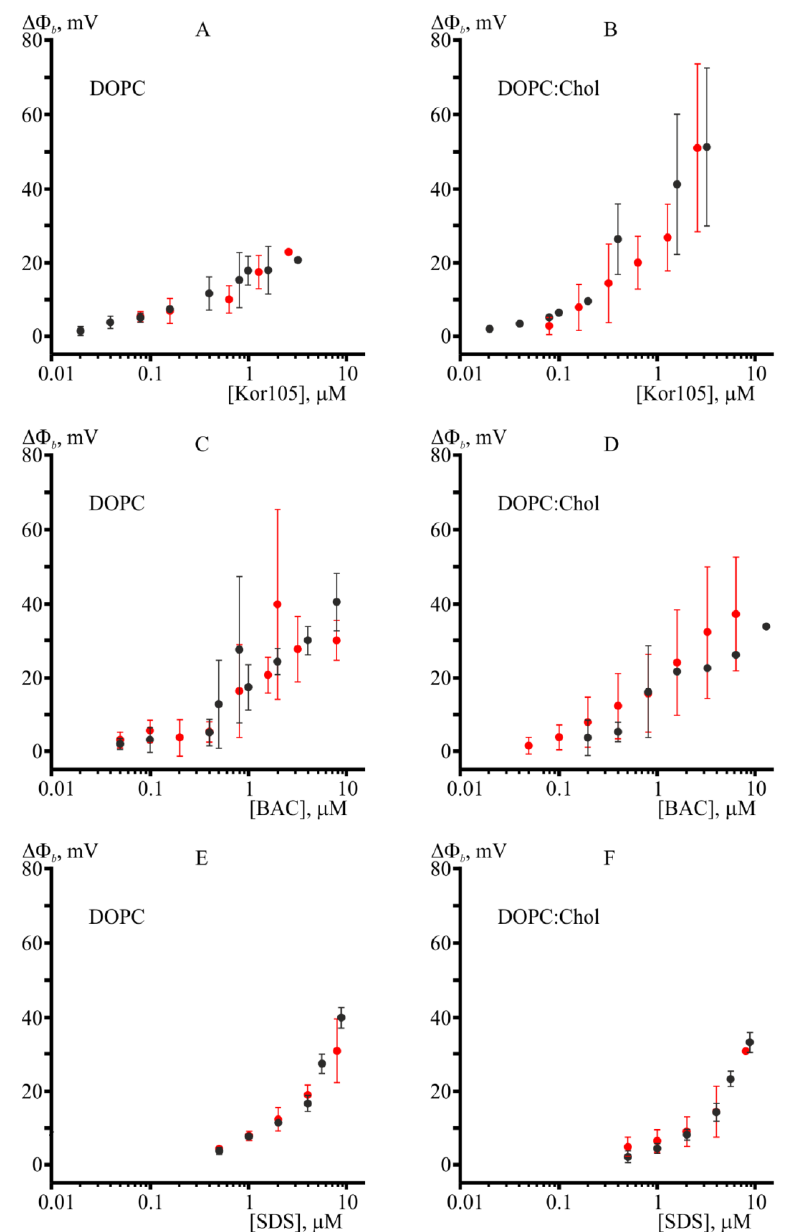
Figure 3. BAC, Kor105, and sodium dodecyl sulfate (SDS) adsorption onto and penetration into bilayer lipid membranes (BLMs). Panels A and B show the boundary potential difference measured after the addition of increasing concentrations of Kor105. Panels C and D show the boundary potential difference measured after the addition of increasing concentrations of BAC. Panels E and F show the sign-inversed boundary potential difference measured after the addition of increasing concentrations of SDS. Membranes formed from 1,2-dioleoyl- sn -glycero-3-phosphocholine (DOPC) correspond to panels A, C, and E. Membranes formed from DOPC/cholesterol (Chol) 3:2 correspond to panels B, D, and F . Boundary potential differences (∆Φ b ) were measured using the inner field compensation (IFC) method (black solid circles) and nonactin conductance (red solid circles).